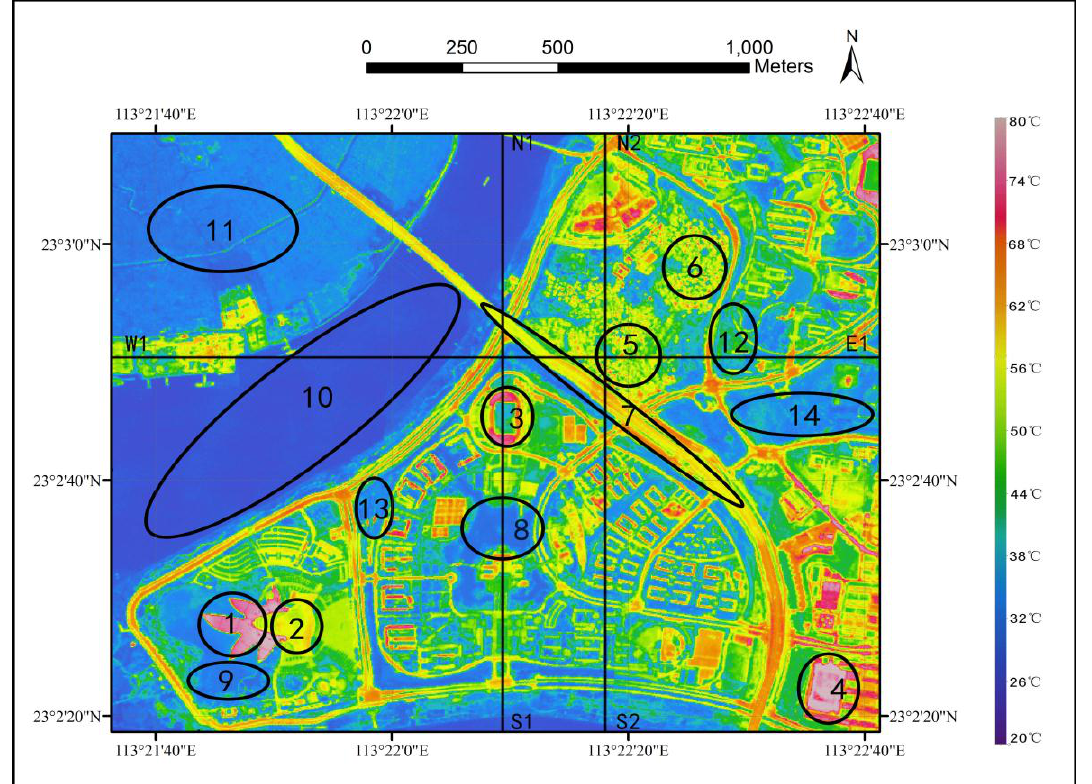
Figure 9. LST distribution in Guangzhou university